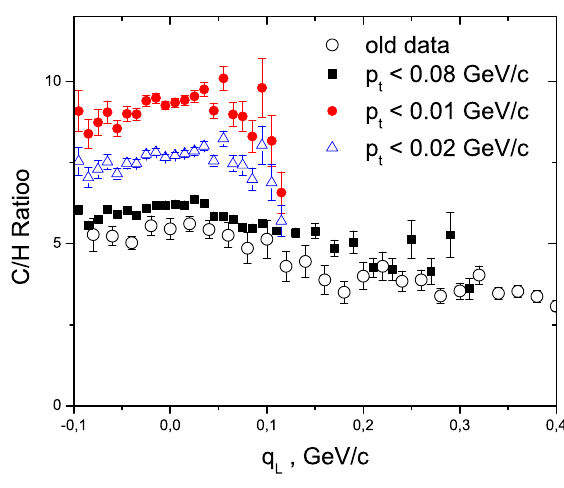
Figure 2. 12 C ( d , p ) X / 1 H ( d , p ) X ratios at di ff erent transversal momentum